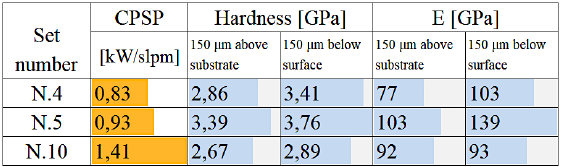
Table 2. Resulst of nanoindentation correlated to CPSP parametr